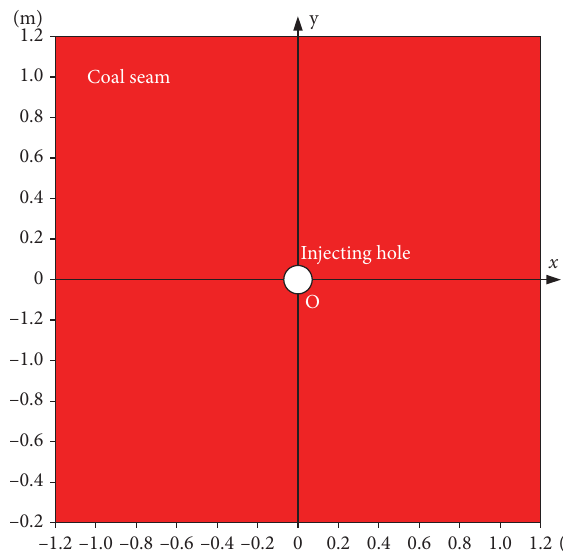
Figure 7: Calculation